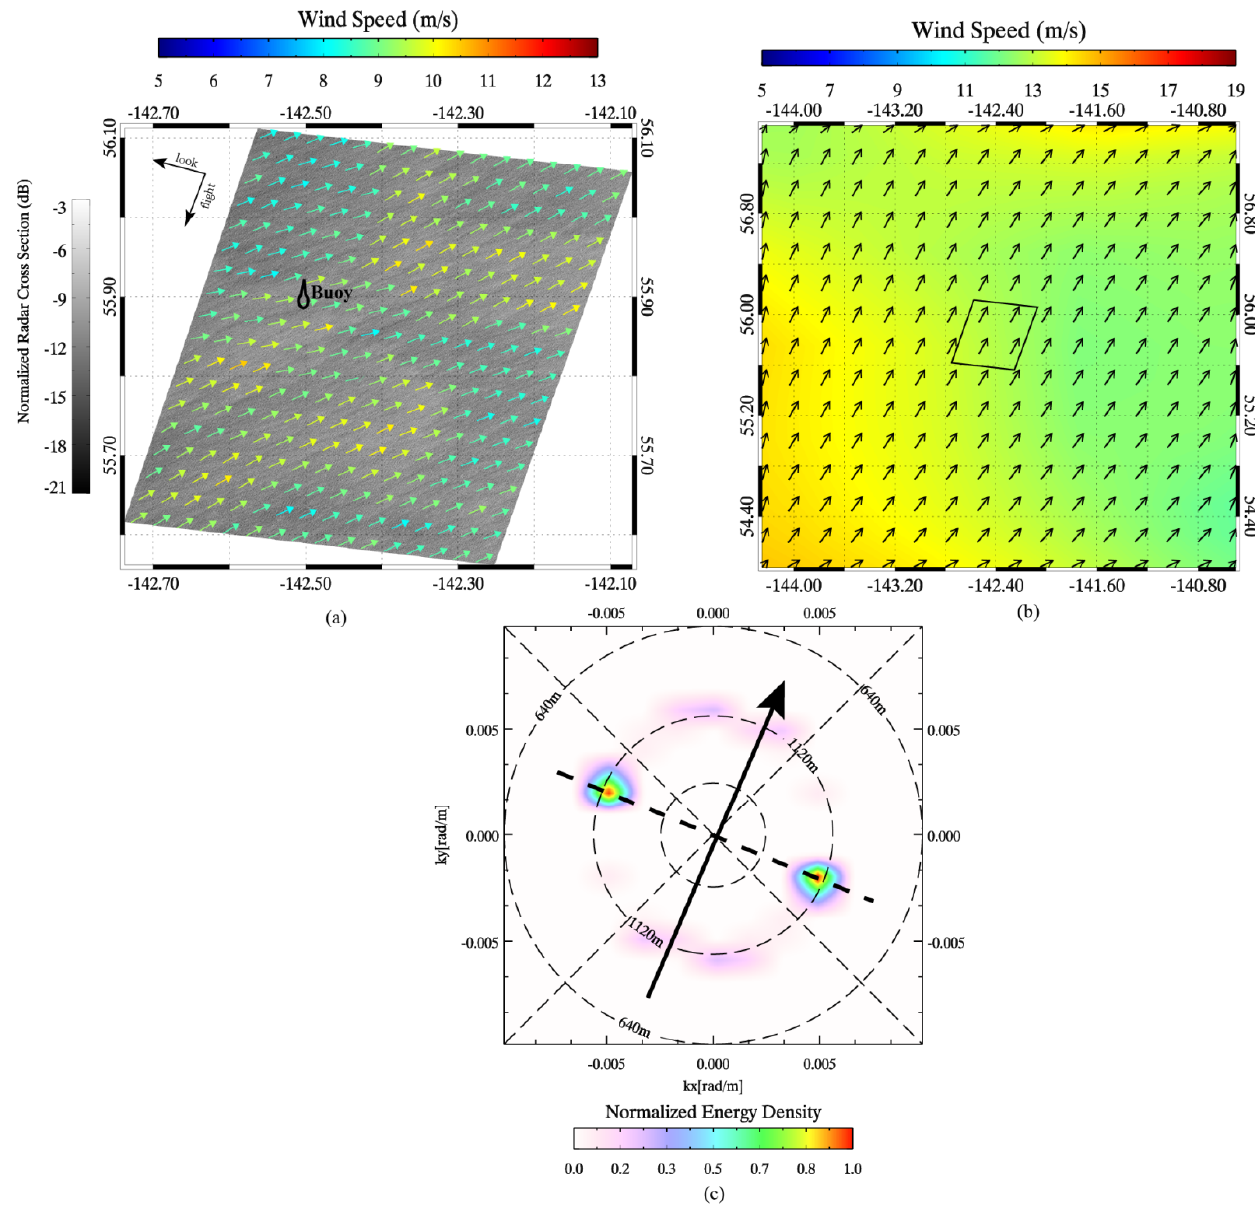
Figure 1. ( a ) The quick-look example of HH-polarization TS-X image taken at 3:54 p.m. UTC on 29 October 2011 after calibration and wind field retrieval with the corresponding buoy; ( b ) ECMWF wind field collected at 6:00 p.m., noting that the black rectangle represents the geographic location of TS-X; and ( c ) the black arrow represents the wind direction derived from TS-X at the buoy